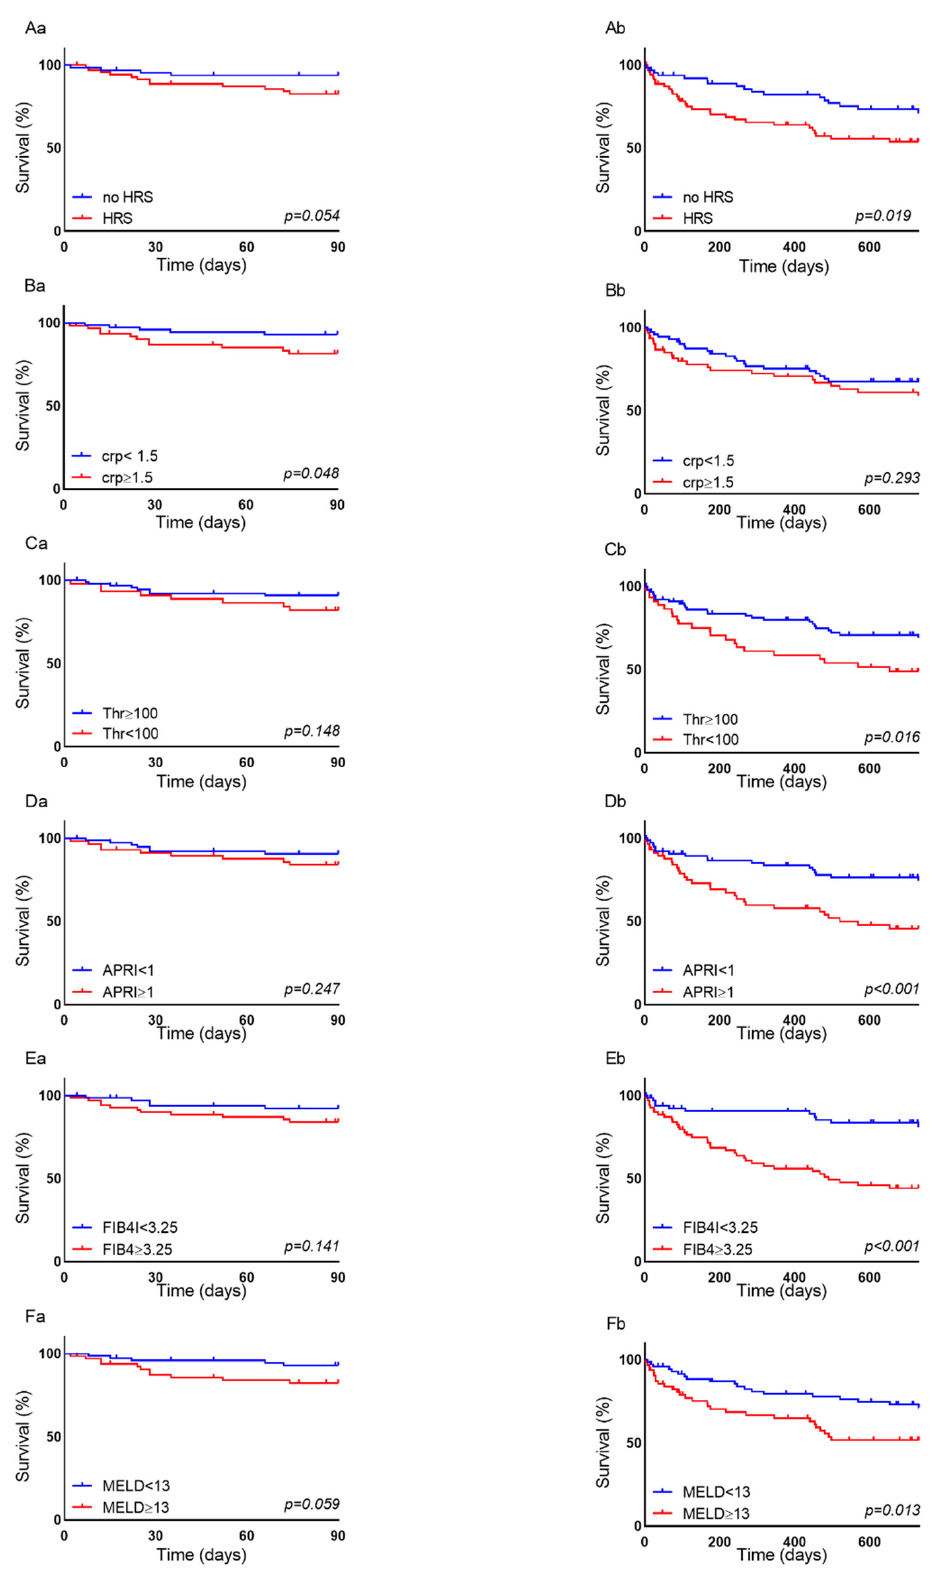
Figure 2. 90 days ( a ) and 730 days ( b ) LTF survival of TIPS patients dependent on ( A ) HRS in the history (HRS vs. no HRS), ( B ) CRP levels (<1.5 mg/dL vs. ≥ 1.5 mg/dL), ( C ) platelet count ( ≥ 100/nL vs. <100/nL), ( D ) APRI (<1 vs. ≥ 1), ( E ) FIB-4 (<3.25 vs. ≥ 3.25) and ( F ) MELD score (<13 vs. ≥ 13). The p -values were obtained using the logrank test.